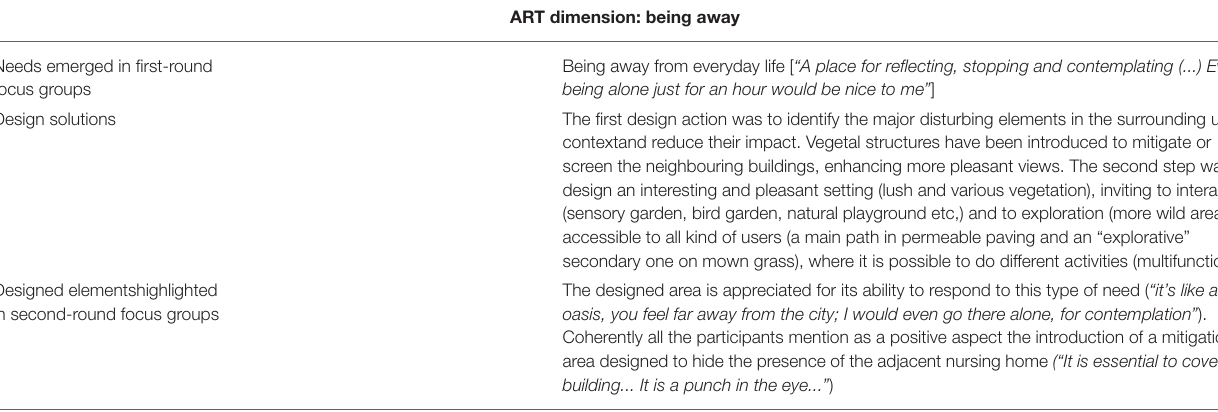
TABLE 4 | Comparison of the needs and reactions of the participants to the design proposal (ART, being away). ART dimension: being away